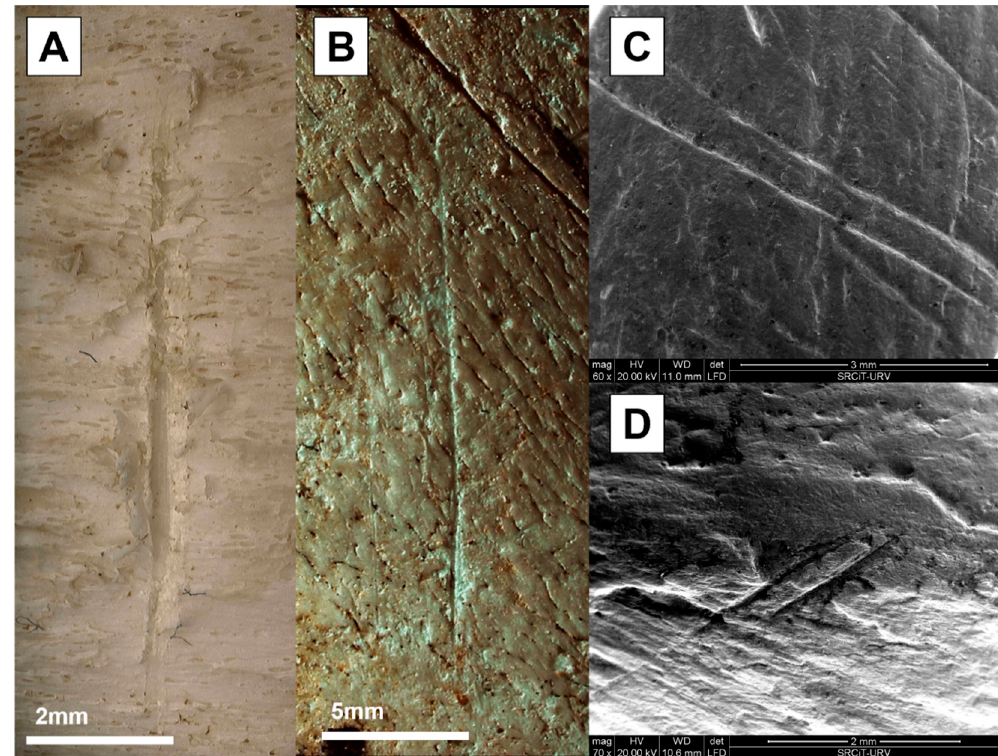
Figure 1. Photographic examples of ( A , B ) experimental and ( C , D ) archaeological taphonomic traces. Photographic documentation using the HIROX KH-8700 microscope of experimental ( A ) cut and ( B ) trampling marks. Scanning Electron Microscope photographs of ( C ) inconspicuous taphonomic traces that could be cut marks and ( D ) clear cut marks found on antelope bone from Frida Leakey Korongo West of the Olduvai Gorge (Tanzania). Photos by L.A.C. Archaeological remains studied first by J.Y. [35] and later by L.A.C.